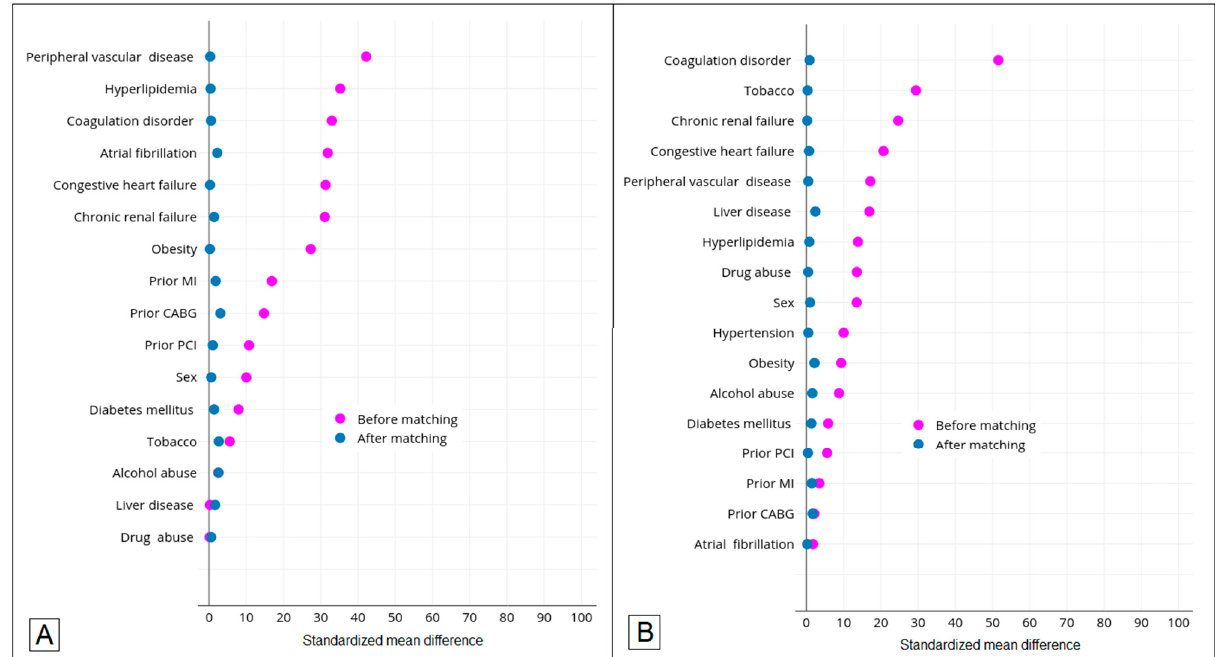
Figure 2. Standardized mean differences between variables before and after propensity score matching for ( A ) COVID-19 hospitalizations with AIS and COVID-19 hospitalizations without AIS and for ( B ) COVID-19 hospitalizations with AIS and AIS hospitalizations without COVID-19.